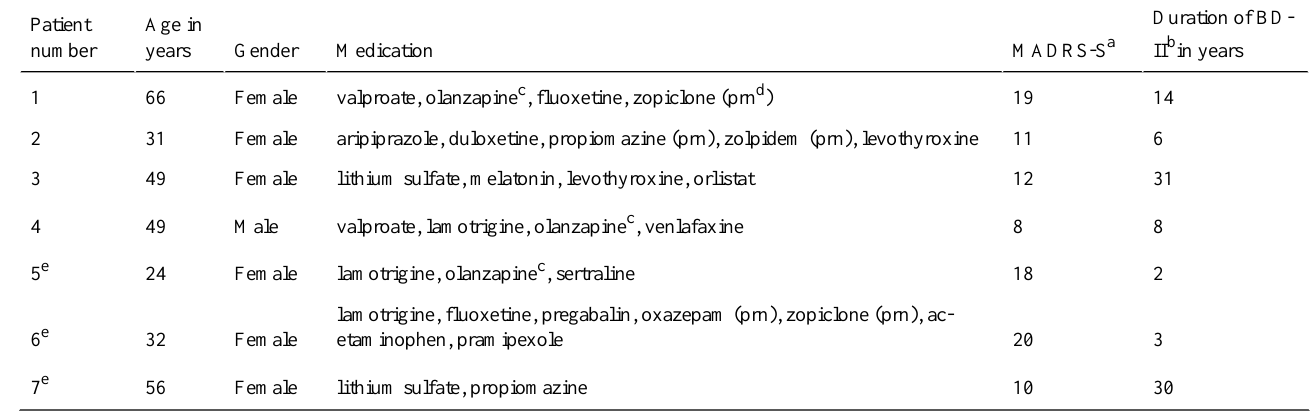
Table 1. Patient characteristics at baseline.